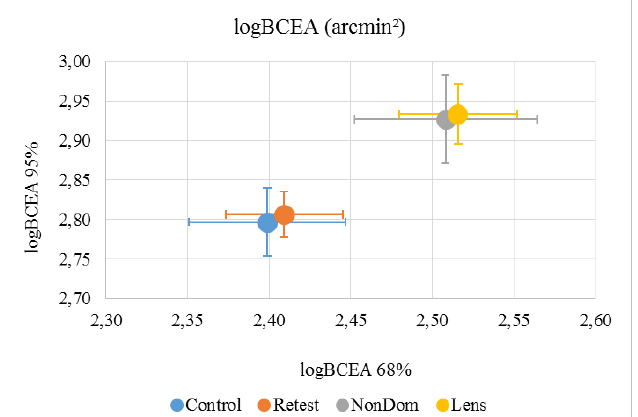
Figure 3. Mean (±standard deviation) logBCEA 68% was 2.40 (±0.16) arcmin² for the ‘Control’ condition, 2.41 (±0.12) arcmin² for the ‘Retest’ condition, 2.51 (±0.19) arcmin² for the ‘NonDom’ condition and 2.52 (±0.12) arcmin² for the ‘Lens’ condition. Mean (±standard devia- tion) logBCEA 95% was 2.80 (±0.14) arcmin² for the ‘Con- trol’ condition, 2.81 (±0.10) arcmin² for the ‘Retest’ condi- tion, 2.93 (±0.19) arcmin² for the ‘NonDom’ condition and 2.93 (±0.13) arcmin² for the ‘Lens’ condition. Error bars represent the standard